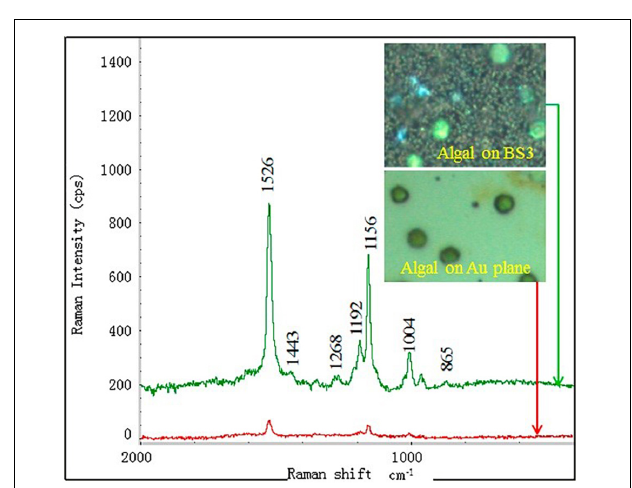
FIGURE 8 | SERS detection of a single algal cell by using the BS3 substrate deposited with 400 nm gold layer. The inset are the images of the algal cells dispersed at the substrates taken from the optical microscope (86) (Copyright permission: 5179191297869).